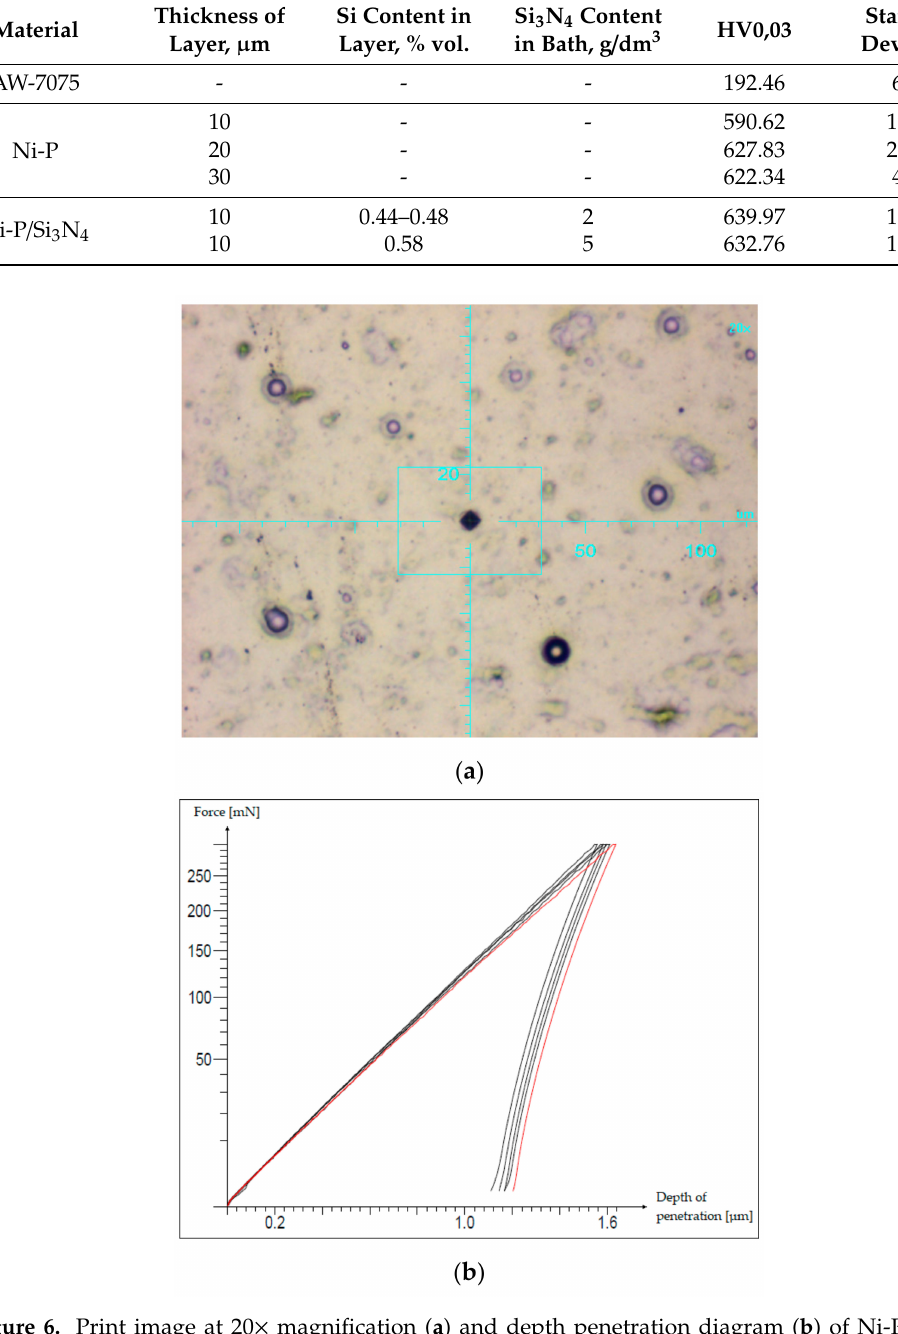
Figure 6. Print image at 20 × magnification ( a ) and depth penetration diagram ( b ) of Ni-P / Si 3 N 4 (2 g / dm 3